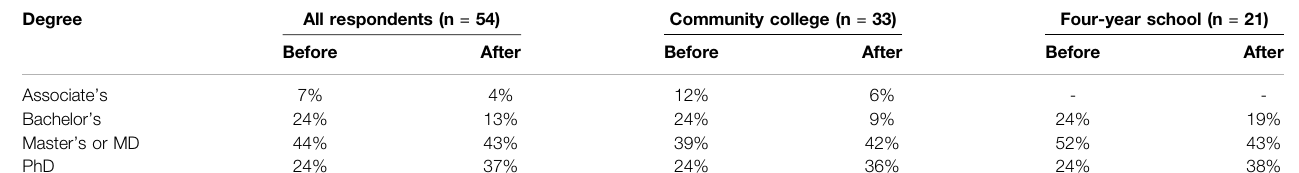
TABLE 2 | Degree plans before and after YGT!. Degree